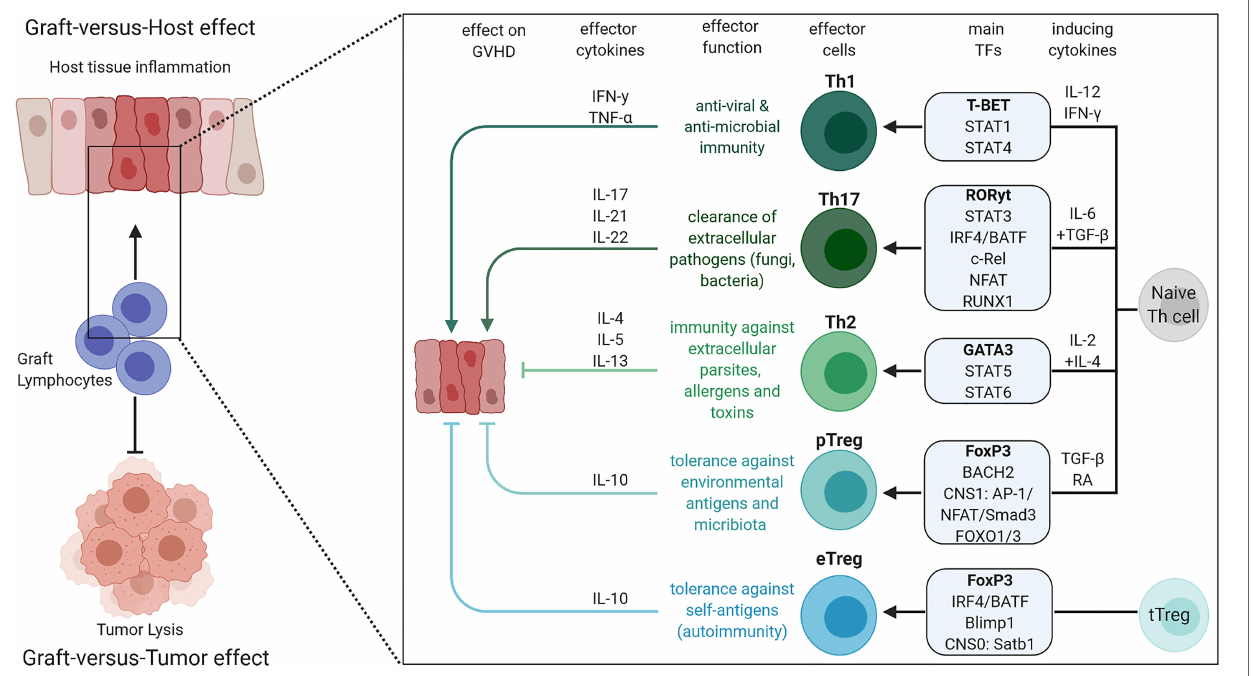
FIGURE 1 | Overview of Th1, Th2, Th17, eTreg and pTreg differentiation, their effector cytokines, roles in the immune system and impact on GVHD. The fi gure was created with